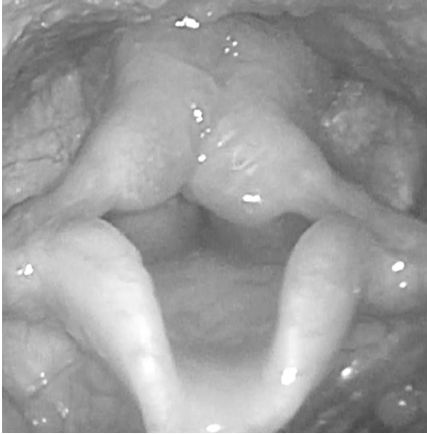
Figure 3: Laryngeal endoscopy revealing swelling in the arytenoid.